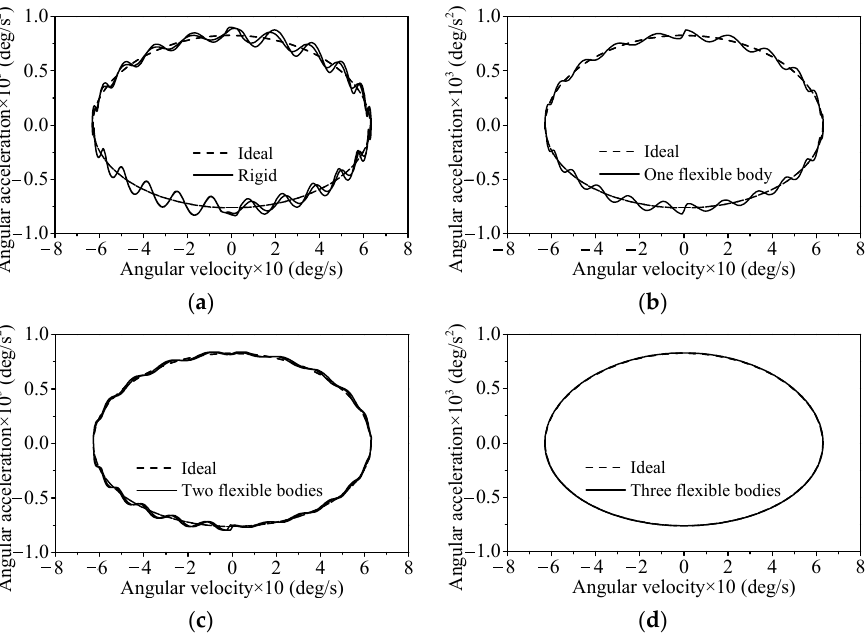
Figure 18. Angular acceleration-angular velocity phase diagram of the rigid-flexible flap actuation system with different flexible body number when considering the single clearance joint: ( a ) rigid; ( b ) one flexible body; ( c ) two flexible bodies; and ( d ) three flexible bodies.